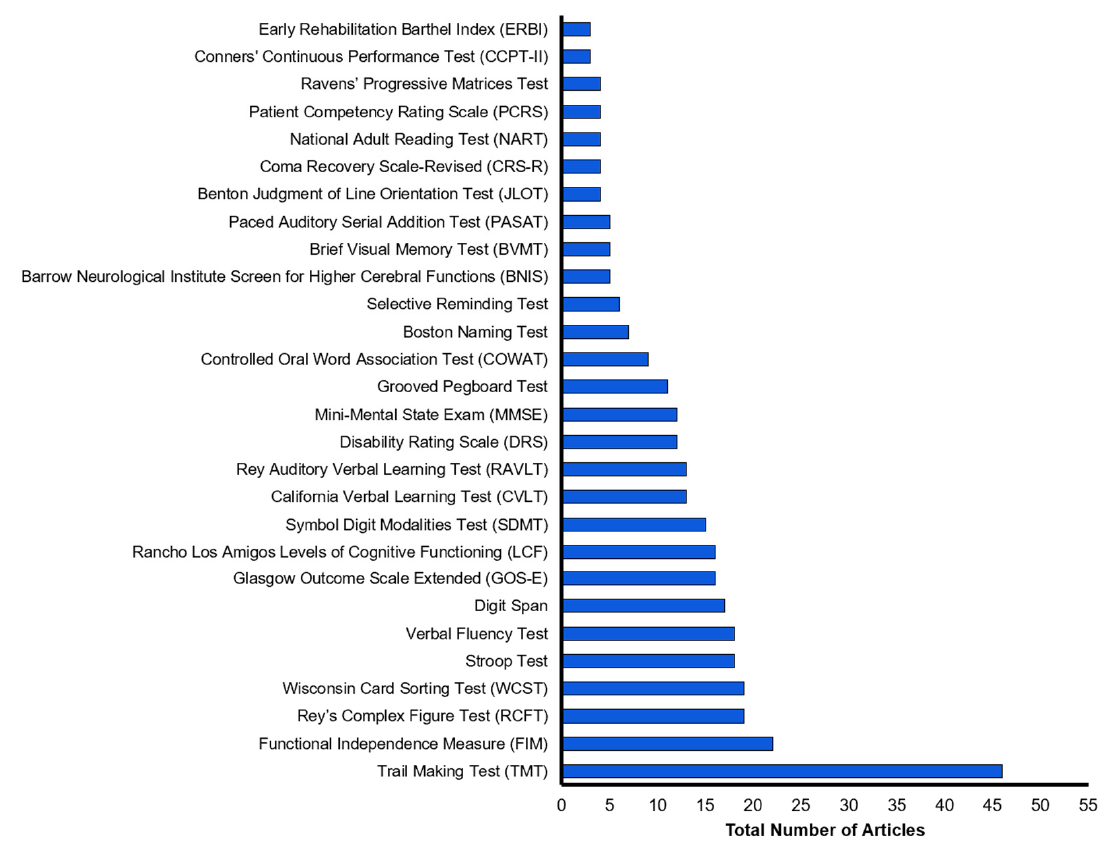
Figure 2. Cognitive instruments using single tests appearing in three or more articles included in this review. Articles are arranged by frequency of appearance.